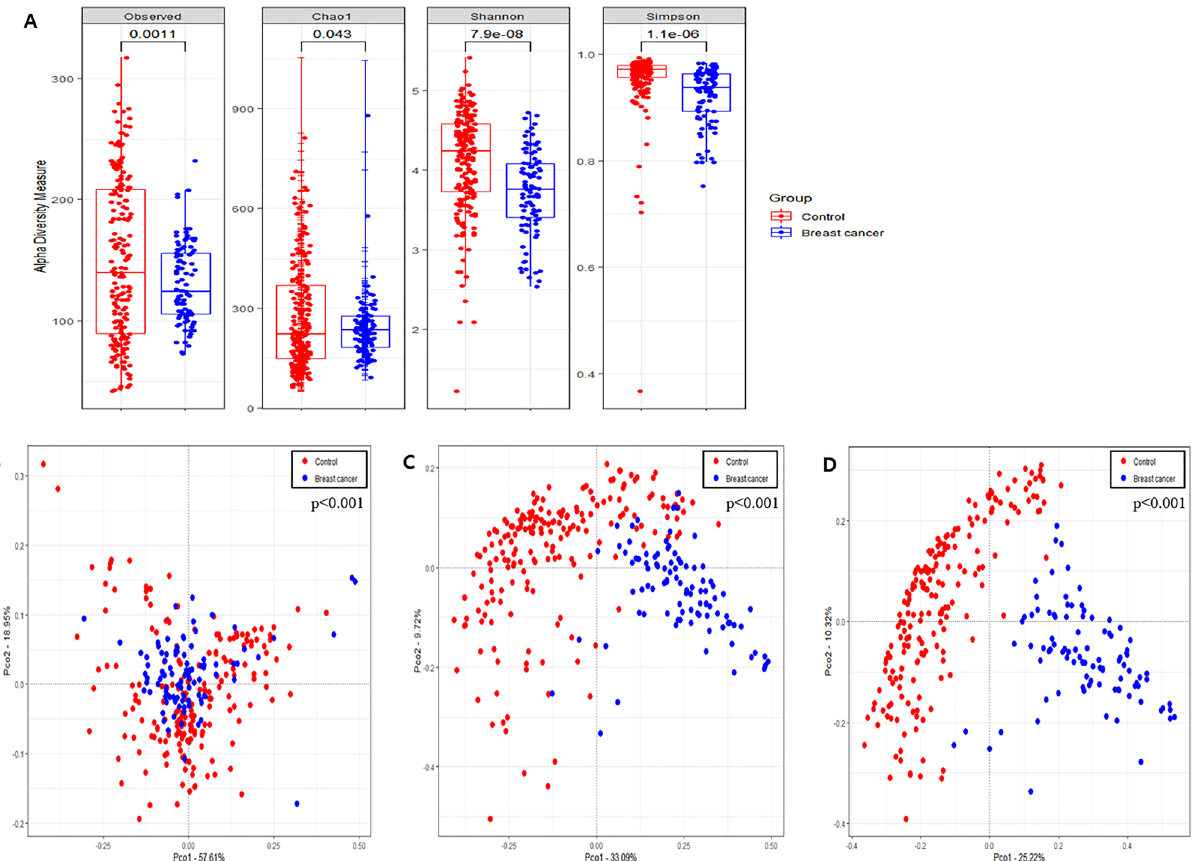
Figure 1. Difference of diversity between breast cancer and healthy control. ( A ) Alpha diversity including Observed OTUs, Chao1 index, Shannon index and Simpson index. Principal Coordinate Analysis (PCoA) at the ( B ) phylum level, ( C ) family level, and ( D ) genus